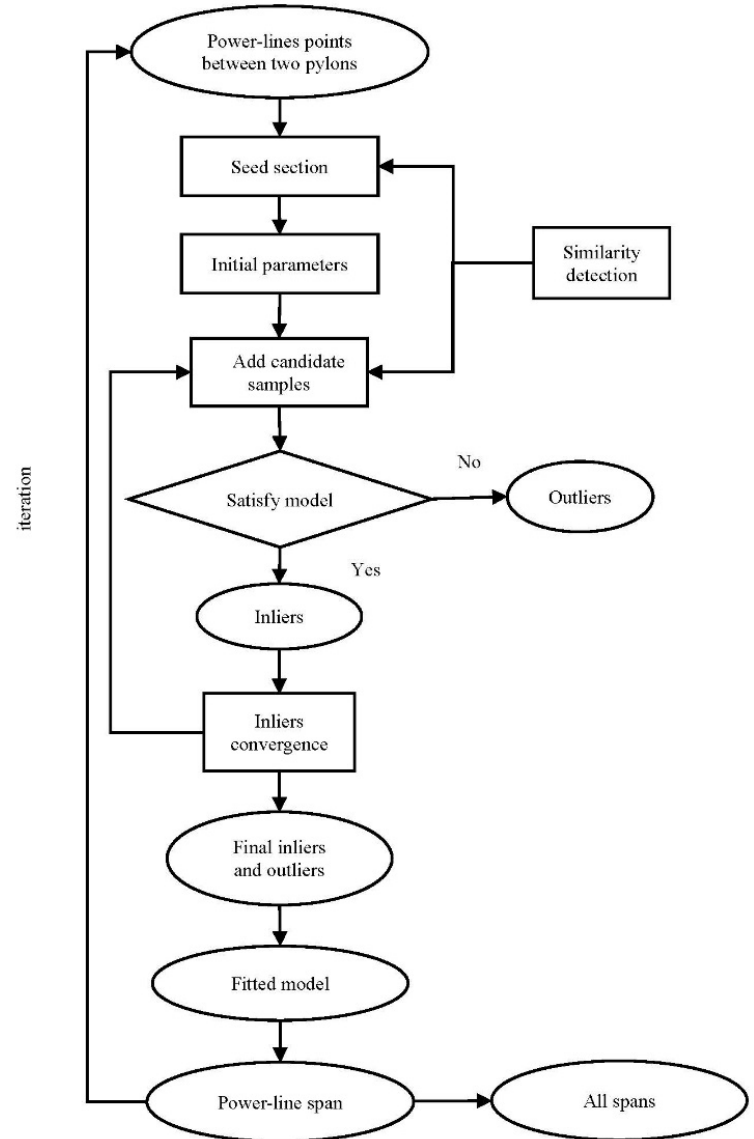
Figure 5. Progress of RANSAC rule for power-line spans reconstruction.